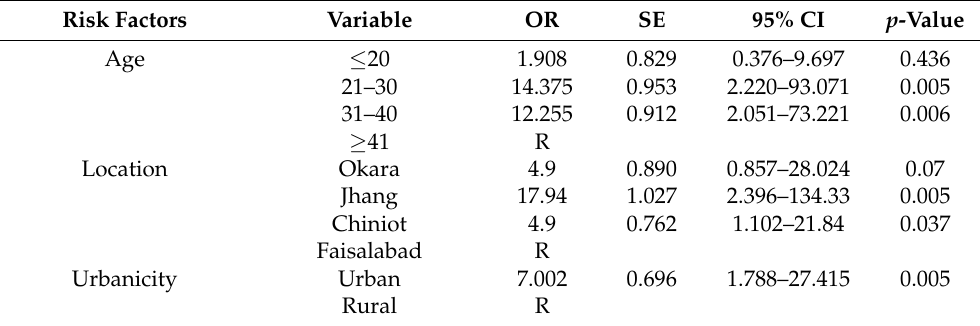
Table 3. Identification of Risk factors associated with Q fever based on seroprevalence in women from four districts of Punjab, Pakistan, by using binary logistic